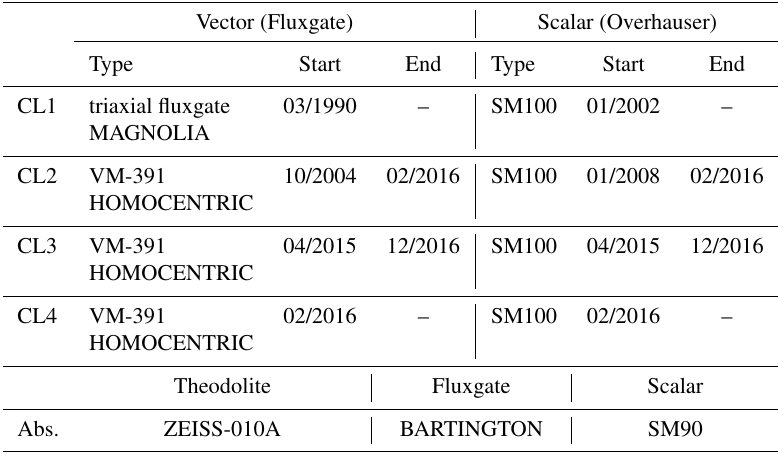
Table 1. List of instruments in place at CLF observatory in 2016. CL1–4 correspond to the different sets of instruments described in the main text; Abs. is the set of instruments used to acquire absolute data.